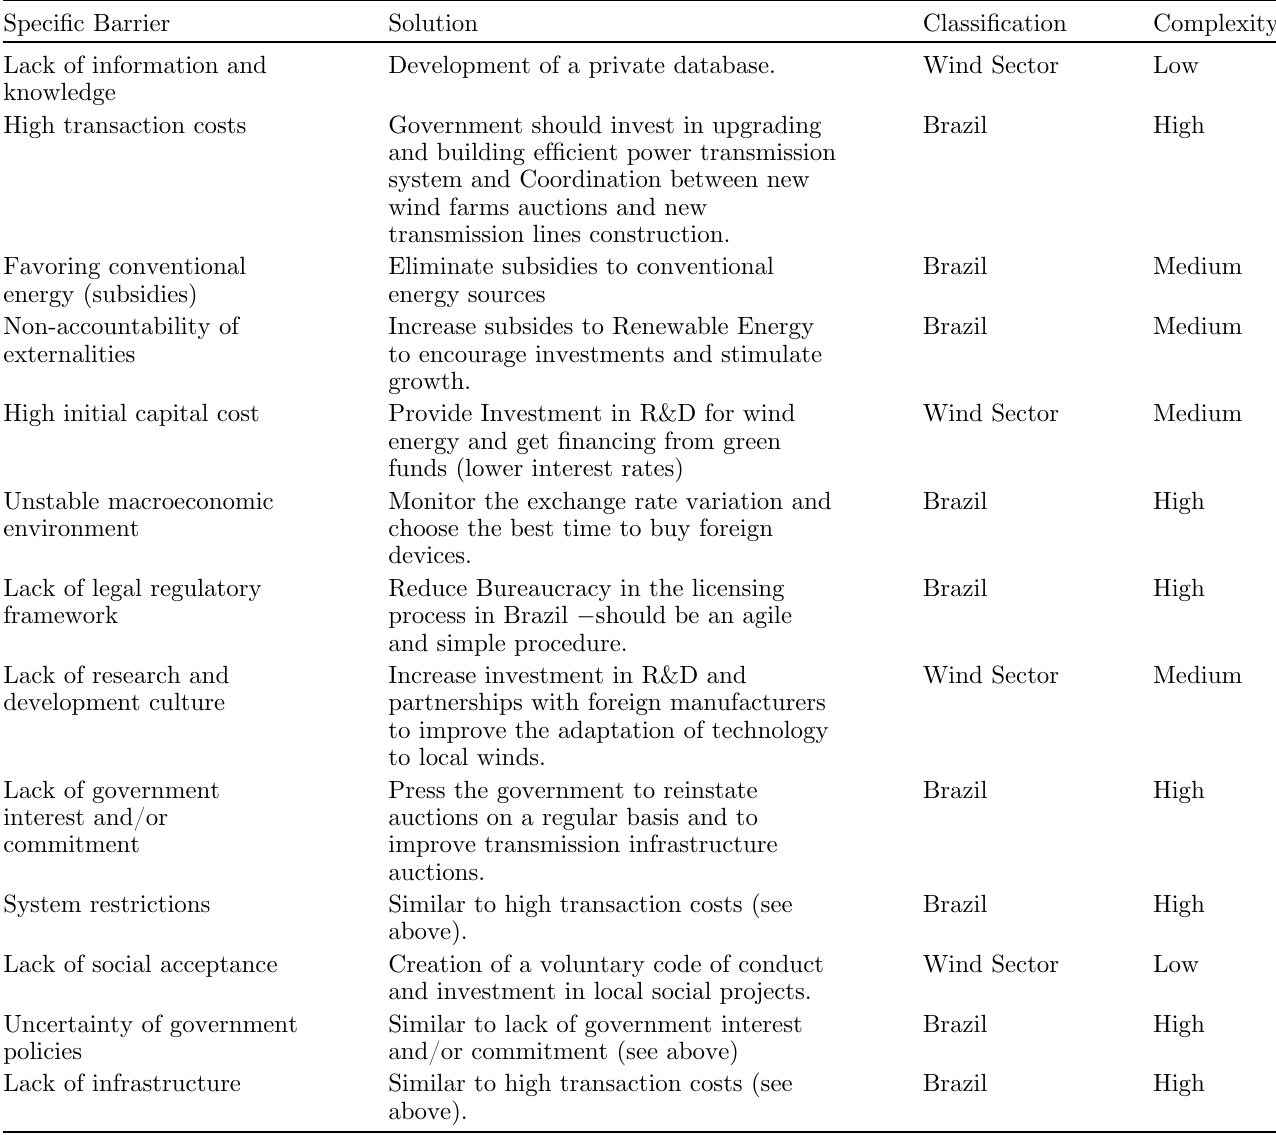
Table 6. Summary of the main barriers to the expansion of wind energy in